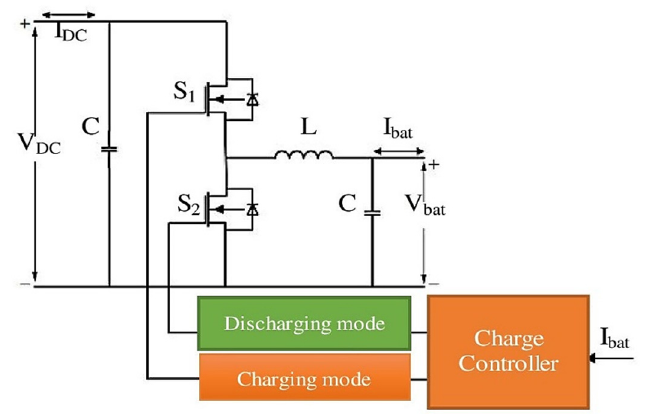
Figure 1. Circuit diagram of the bidirectional converter [2].